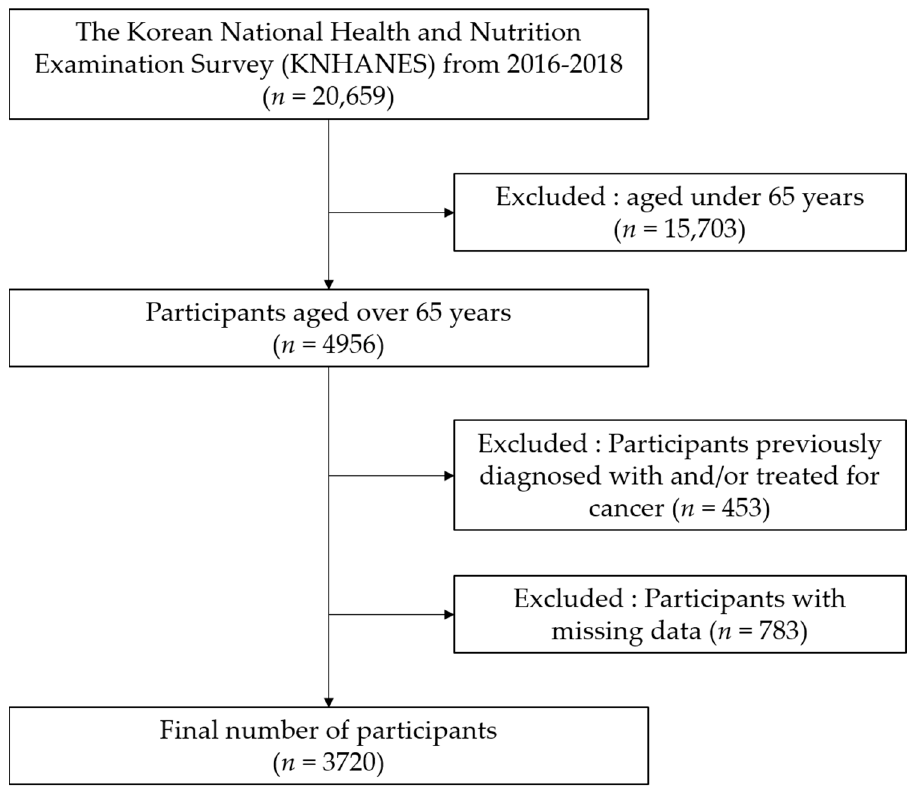
Figure 1. Flow diagram for the selection of study participants.